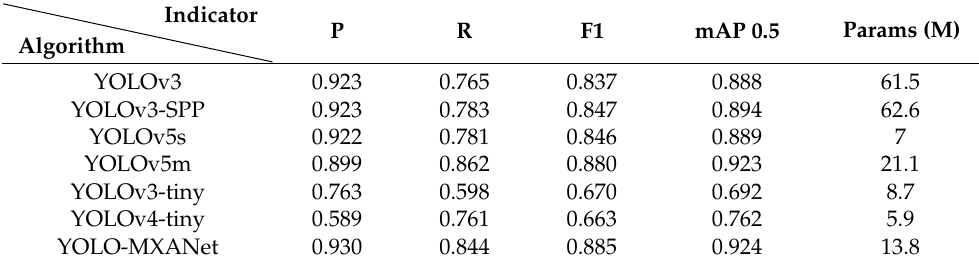
Table 2. The comparison results of the algorithms on the KITTI